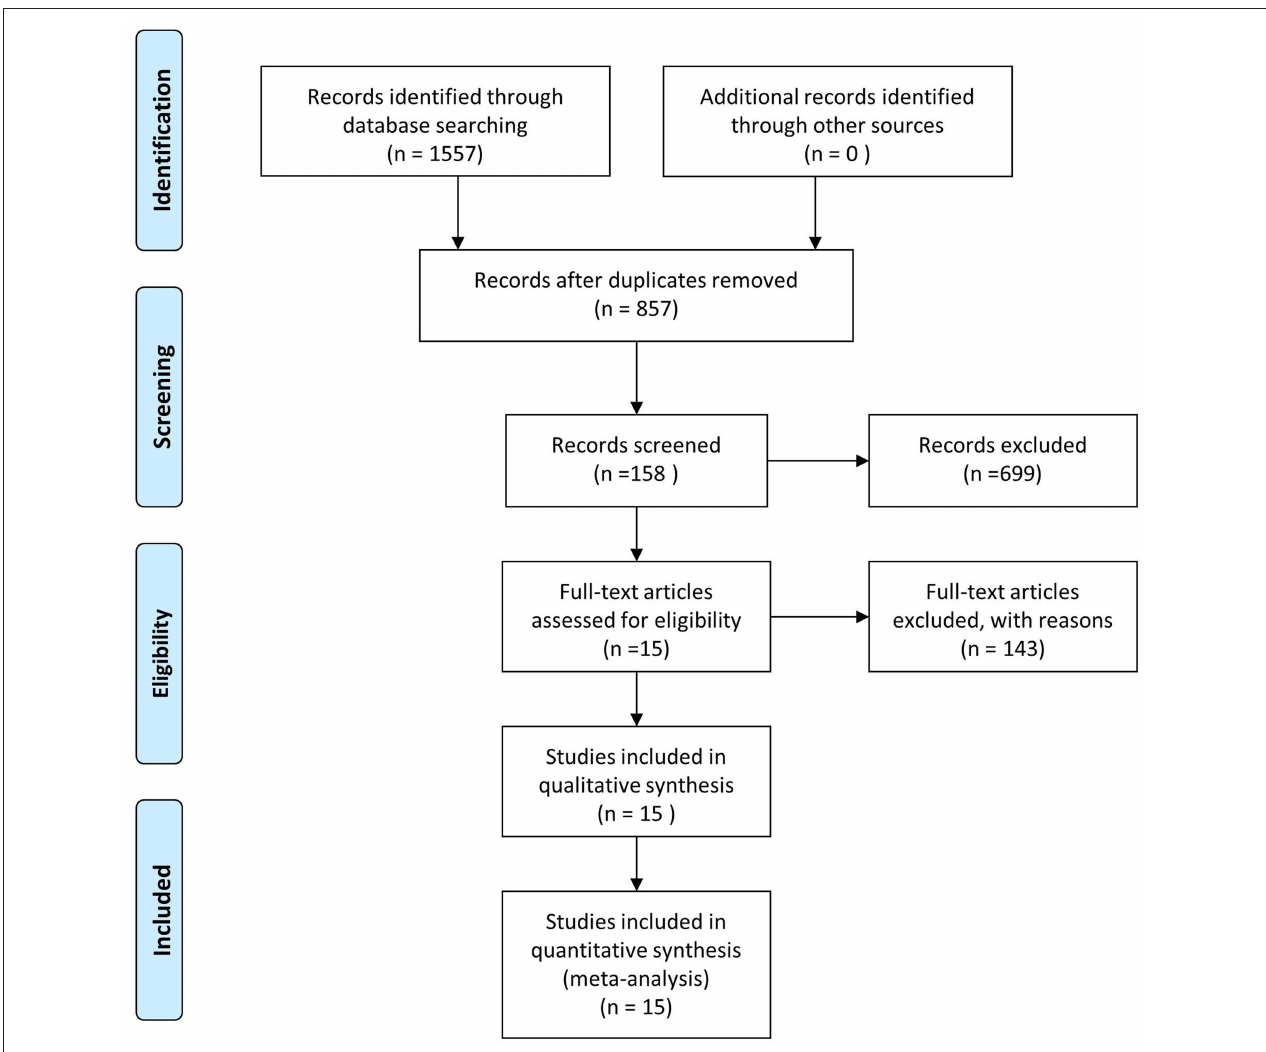
FIGURE 1 | Schematic diagram of the study selection and exclusion procedure for the